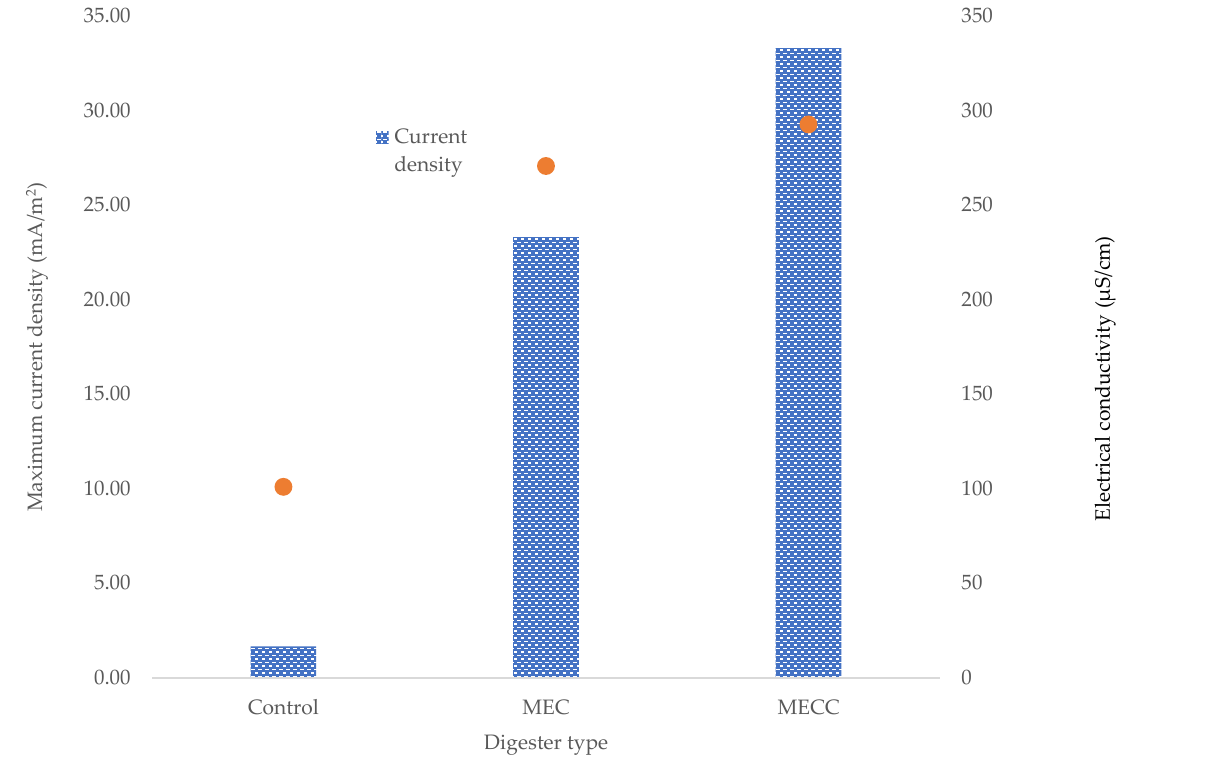
where B is magnetic field intensity (T), μ 0 denotes permeability of free space (T.m/A), N is the number of turns, I is current density (A), and R is the radius (m). For the whole duration of the digestion period, the MECC had higher magnetic field strengths than both MEC and control, owing to the high current.